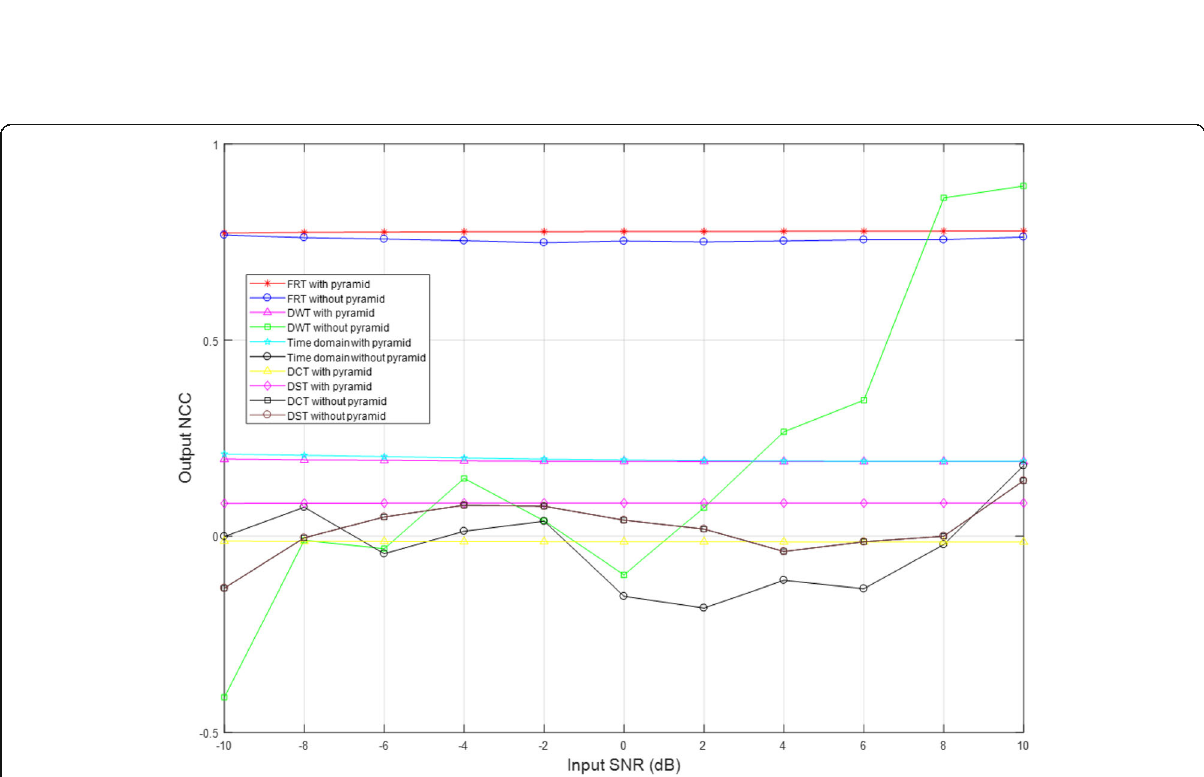
Fig. 18 Output NCC vs. input SNR for Baboon image overall separation